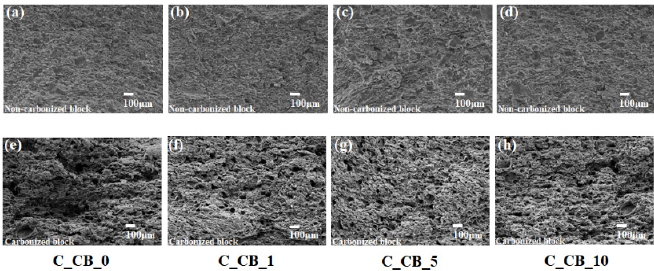
Figure 1. Images of before and after carbonized blocks.